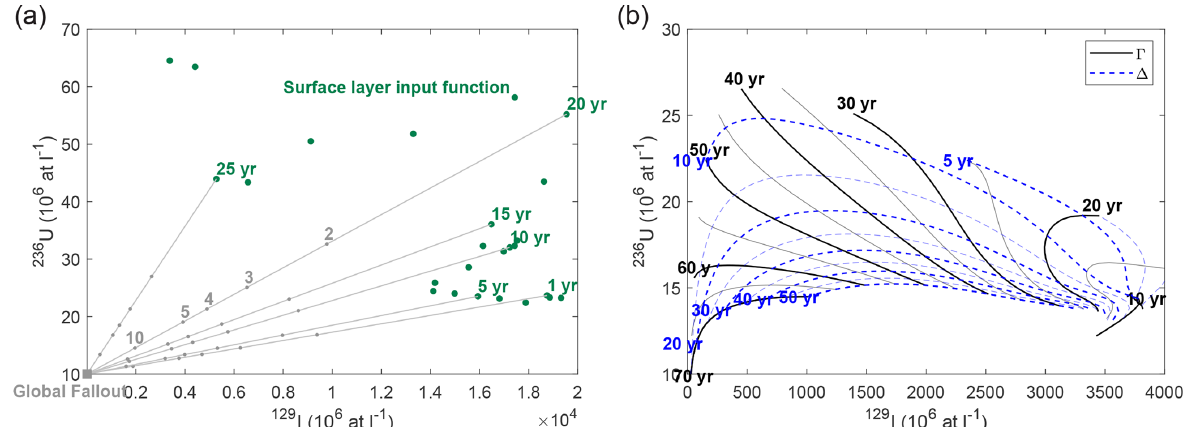
Figure 2. (a) Concept of the binary mixing model with a constant global fallout endmember (gray square) and a time-dependent surface layer input function (green dots with corresponding tracer ages, based on a collection year of 2019) in 236 U vs. 129 I tracer space. Tracer age curves converge towards the global fallout endmember at 1 × 10 7 atomsL − 1 for 129 I and 236 U. Gray numbers denote different dilution factors of the input function. (b) Concept of the TTD model with (cid:48) (black) and (cid:49) (blue) isolines in 236 U vs. 129 I tracer space, calculated from the Atlantic layer input functions for 2019. Numbers denote (cid:48) (mean age, black) and (cid:49) (width of age distribution, blue) values in